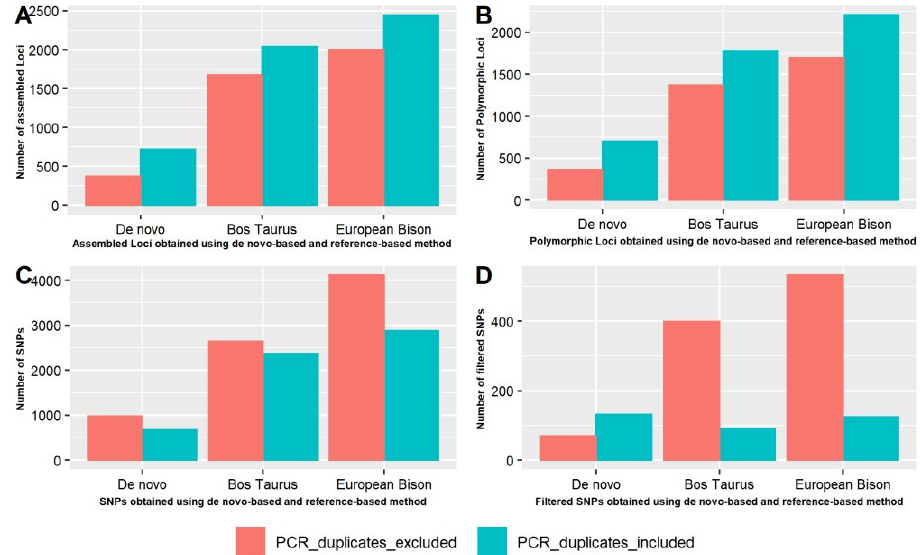
Figure 3. Effect of PCR duplicates on reference pipeline and de novo pipelines. Comparison of ( A ) assembled loci number, ( B ) polymorphic loci number, ( C ) SNP number obtained before filtering, and ( D ) filtered SNPs obtained before and after removing PCR duplicates.